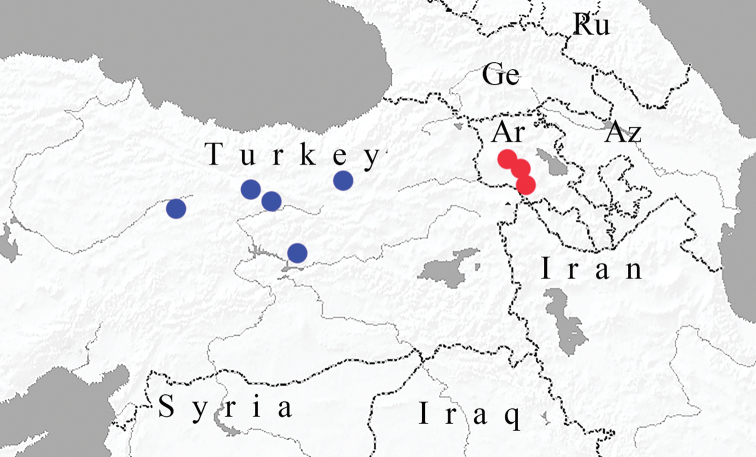
Geographic distribution of P. (A.) eriwanensis
eriwanensis (red circles) and P. (A.) eriwanensis
interjectus (blue circles) based on information from Hesselbarth et al. (1995) and Lukhtanov et al. (2003). Ar is Armenia, Az is Azerbaijan, Ge is Georgia, Ru is Russia.